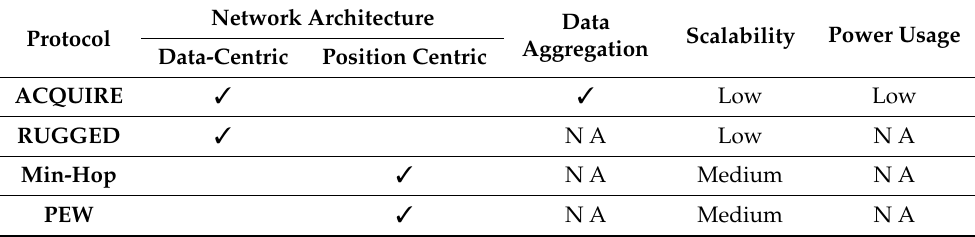
Table 4 establishes a comparison between network architecture-based protocols. Table 4. Network architecture-based